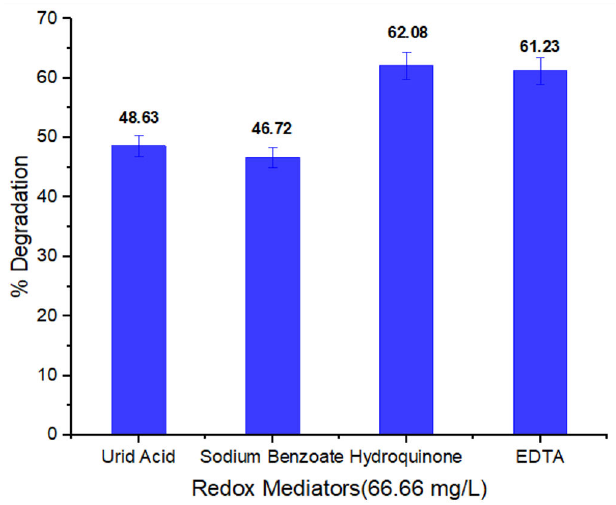
Figure 9. Redox mediators impact on (66.66 mg/L) on methyl red %